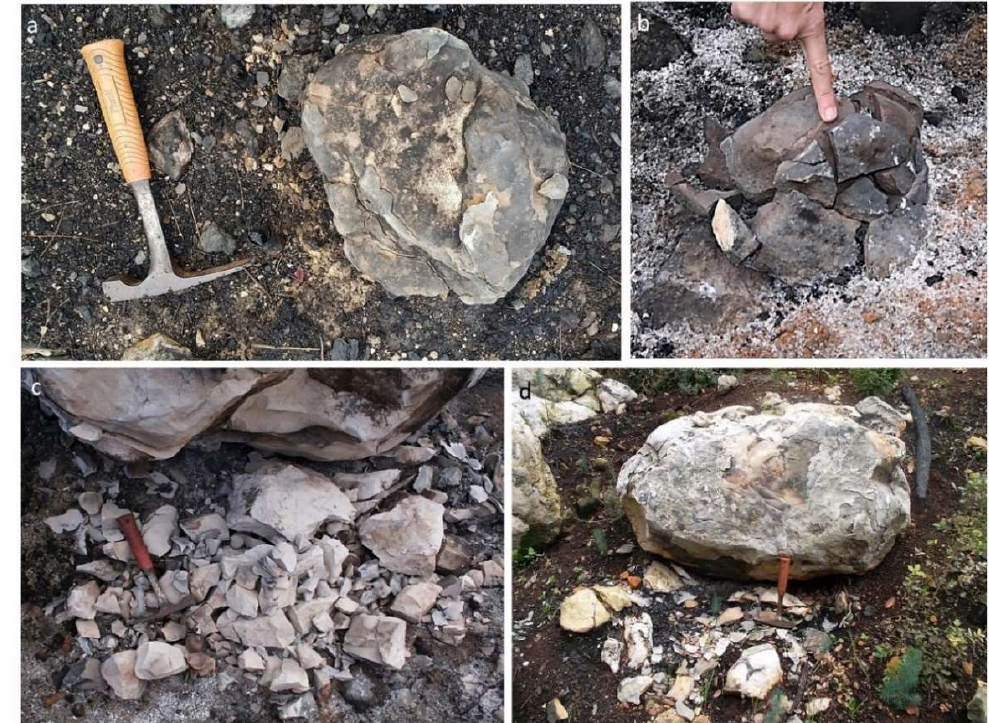
Figure 3. Boulder response to high temperatures: (a + b) moderate size boulders (D < 0.5 m) completely disintegrate and shatter; (c + d) large boulders (D > 0.5) usually exfoliate and partially shatter.